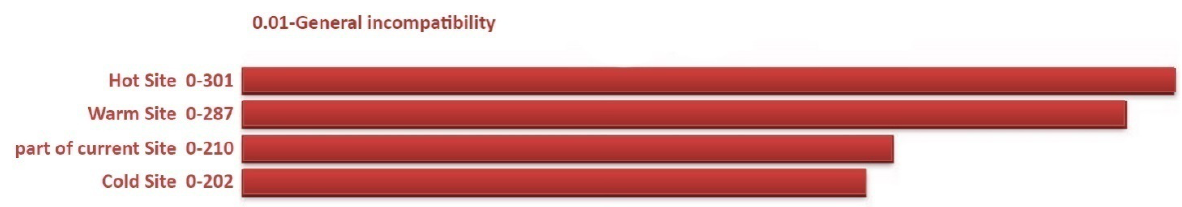
Figure 3. Expert choice results for choosing an alternative